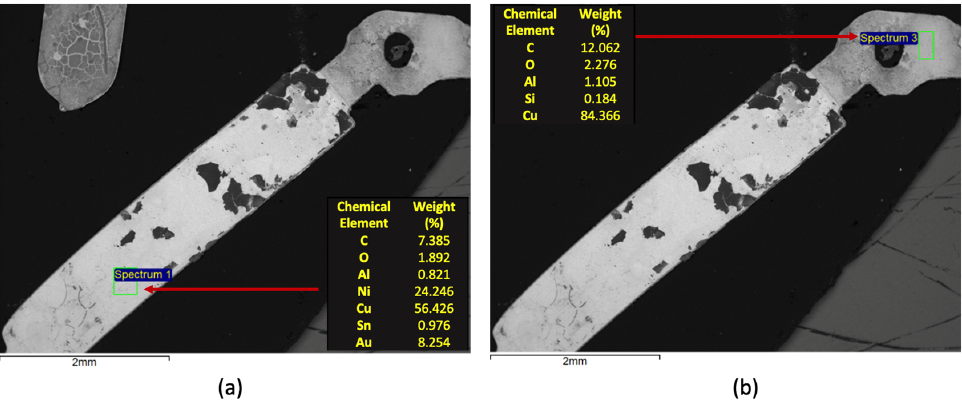
Figure 14. SEM/EDS characterization of the metallic contacts recovered after the size separation and magnetic separation: ( a ) microanalysis of the surface layer; ( b ) microanalysis of the inner contact4. Final Remarks.